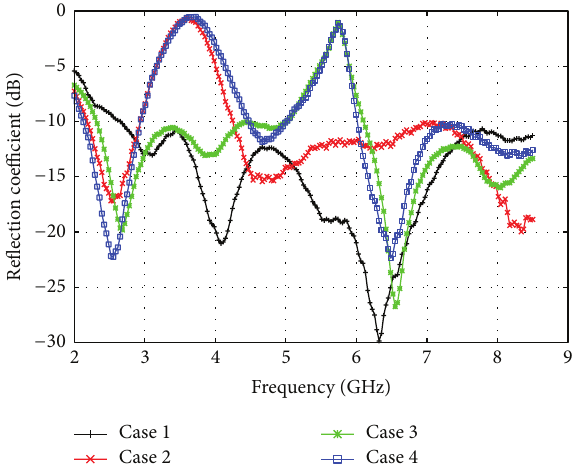
Figure 7: Reflection coefficient for the different switching cases of the antenna in Figure